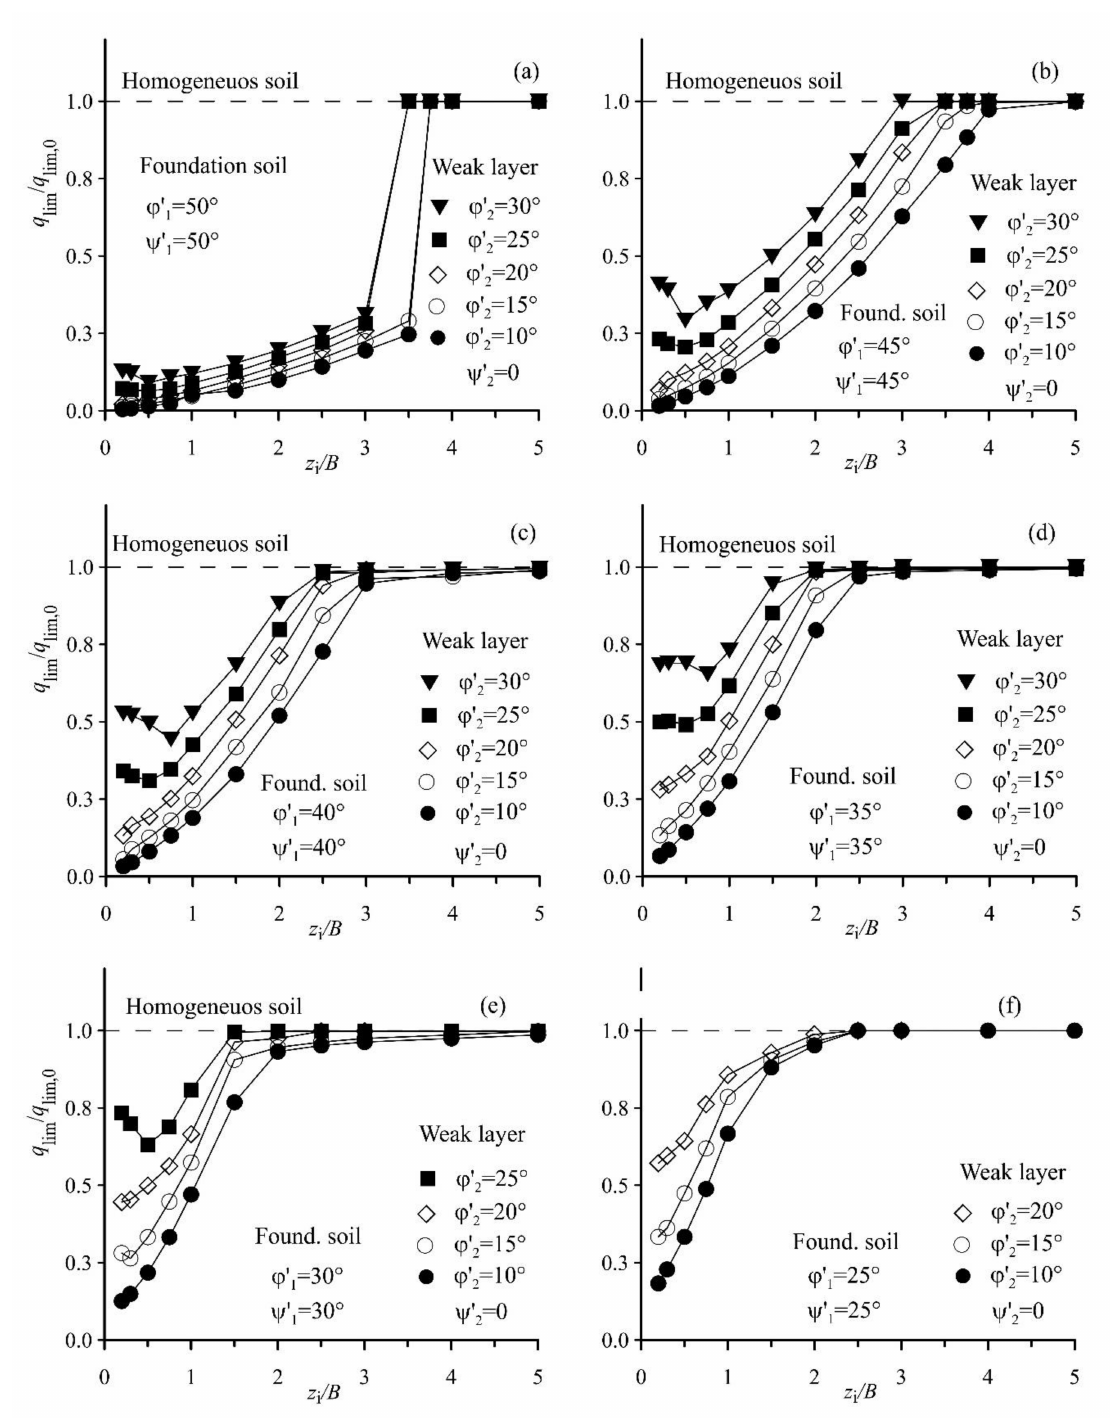
Figure 11. Evolution of the normalised bearing capacity q lim /q lim,0 with the depth of the weak layer z i /B, for different values of the shear strength angle of the foundation soil ϕ (cid:48) 1 and the weak layer ϕ (cid:48) 2 . Calculations were performed considering both the values of dilation angle ψ (cid:48) 1 and ψ (cid:48) 2 of the foundation soil and the weak layer ranging from zero to the value of the angle of shear strength ϕ (cid:48) 1 and ϕ (cid:48) 2 , respectively. However, Figure 11 reports only results relative to (cid:54) = ψ (cid:48) (cid:54) = 0 present similar trends, ϕ (cid:48) ψ (cid:48) ψ (cid:48) ϕ (cid:48) ψ (cid:48) 1 = 1 and 2 = 0. Results obtained for 1 1 and 2 and hence have been omitted, without the study losing